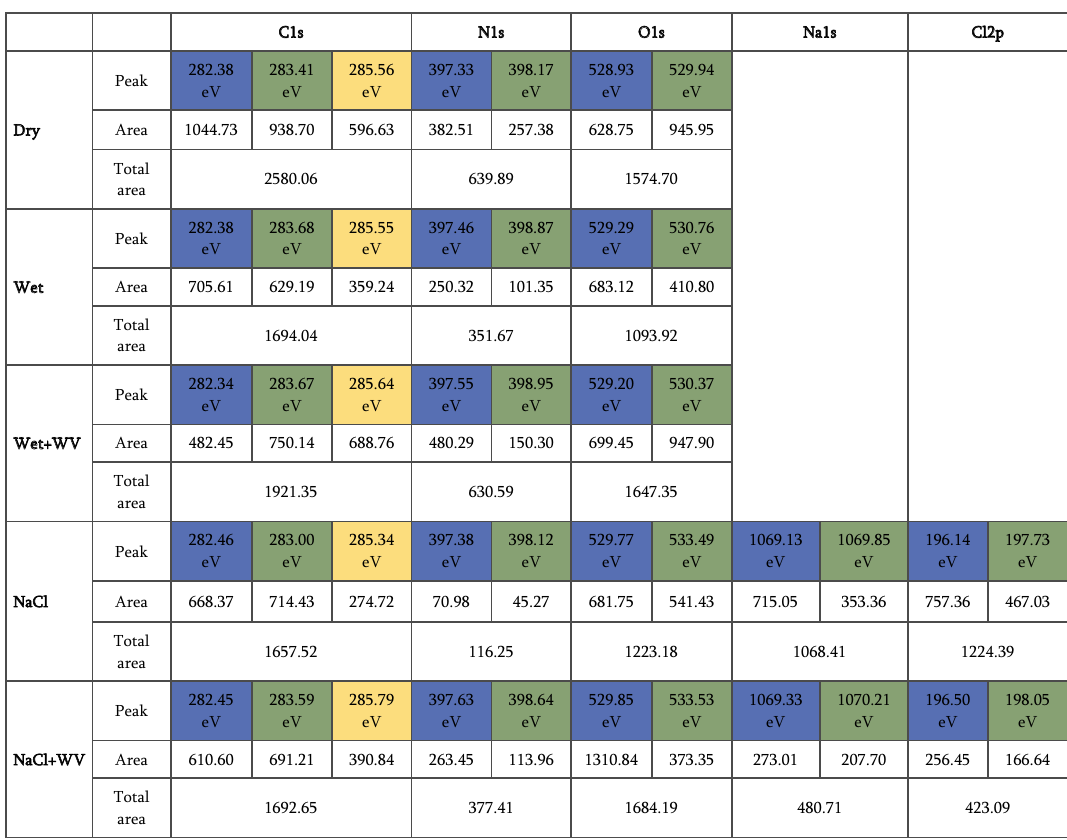
Table 1. The binding energies from the narrow spectra for each constituting element under different conditions. WV stands for water vapor. Blue, green, and yellow color XPS peaks code lowest to the highest binding energy. The corresponding binding energy values with respective color coding are available in the Table 1 and tallies with Figs. 5 and